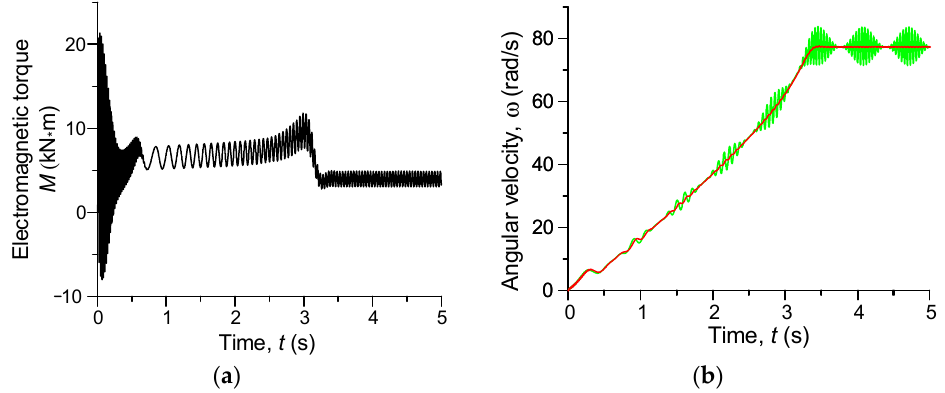
Figure 12. Instantaneous waveforms of: ( a ) electromagnetic torque; ( b ) the moments of torsion in the center of the shaft.